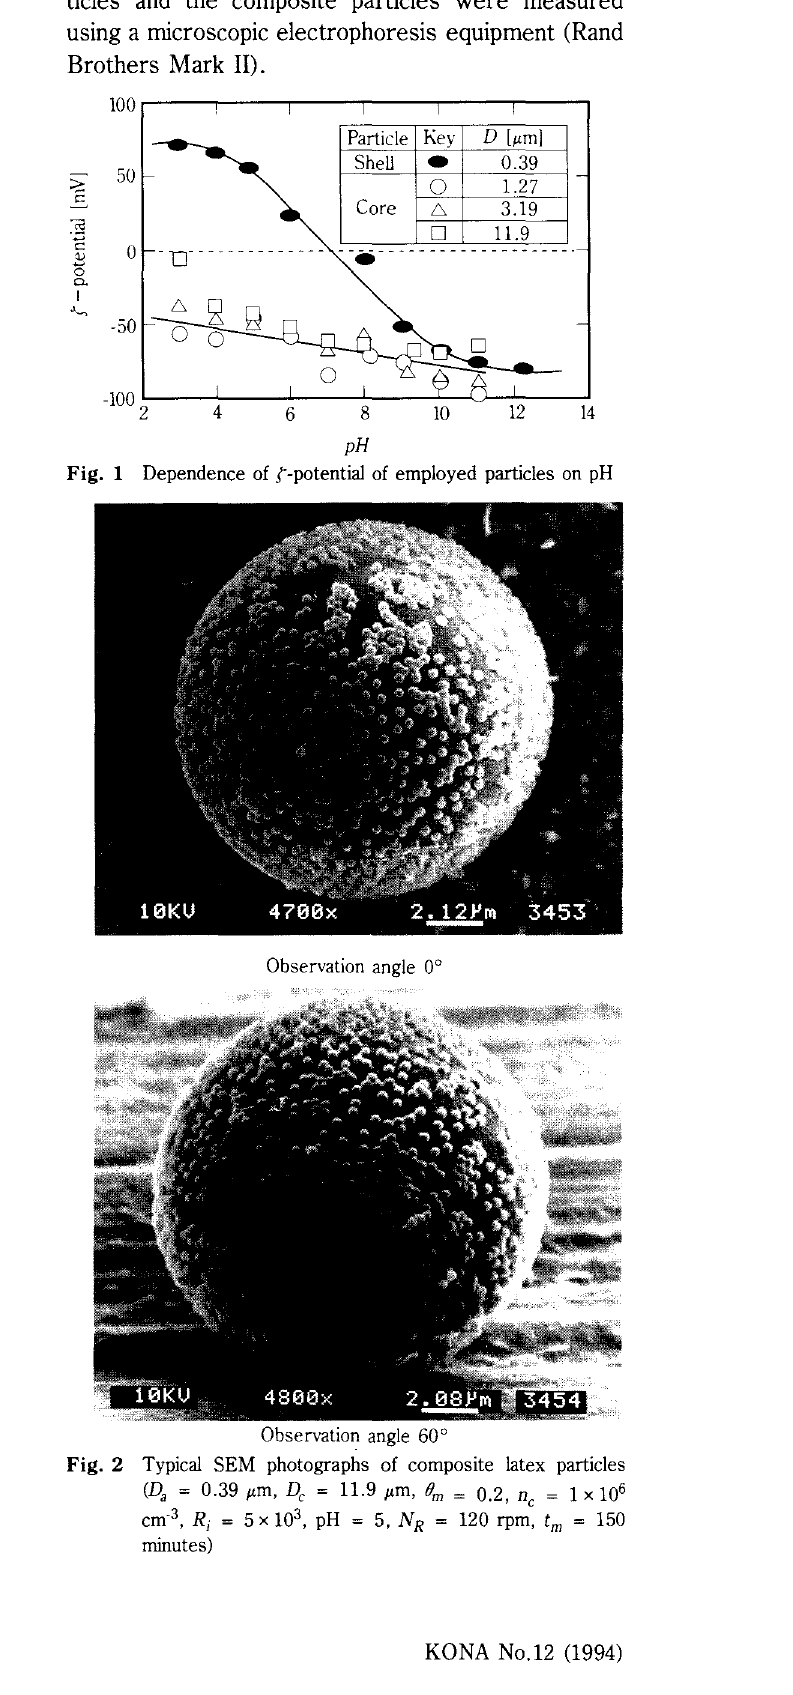
Observation angle 60° Fig. 2 Typical SEM photographs of composite latex particles CDa = 0.39 Jlm, De = 11.9 J.tm, 11m = 0.2, nc = 1 x 10 6 cm· 3, Ri = 5 x 10 3, pH = 5, NR = 120 rpm, tm = 150